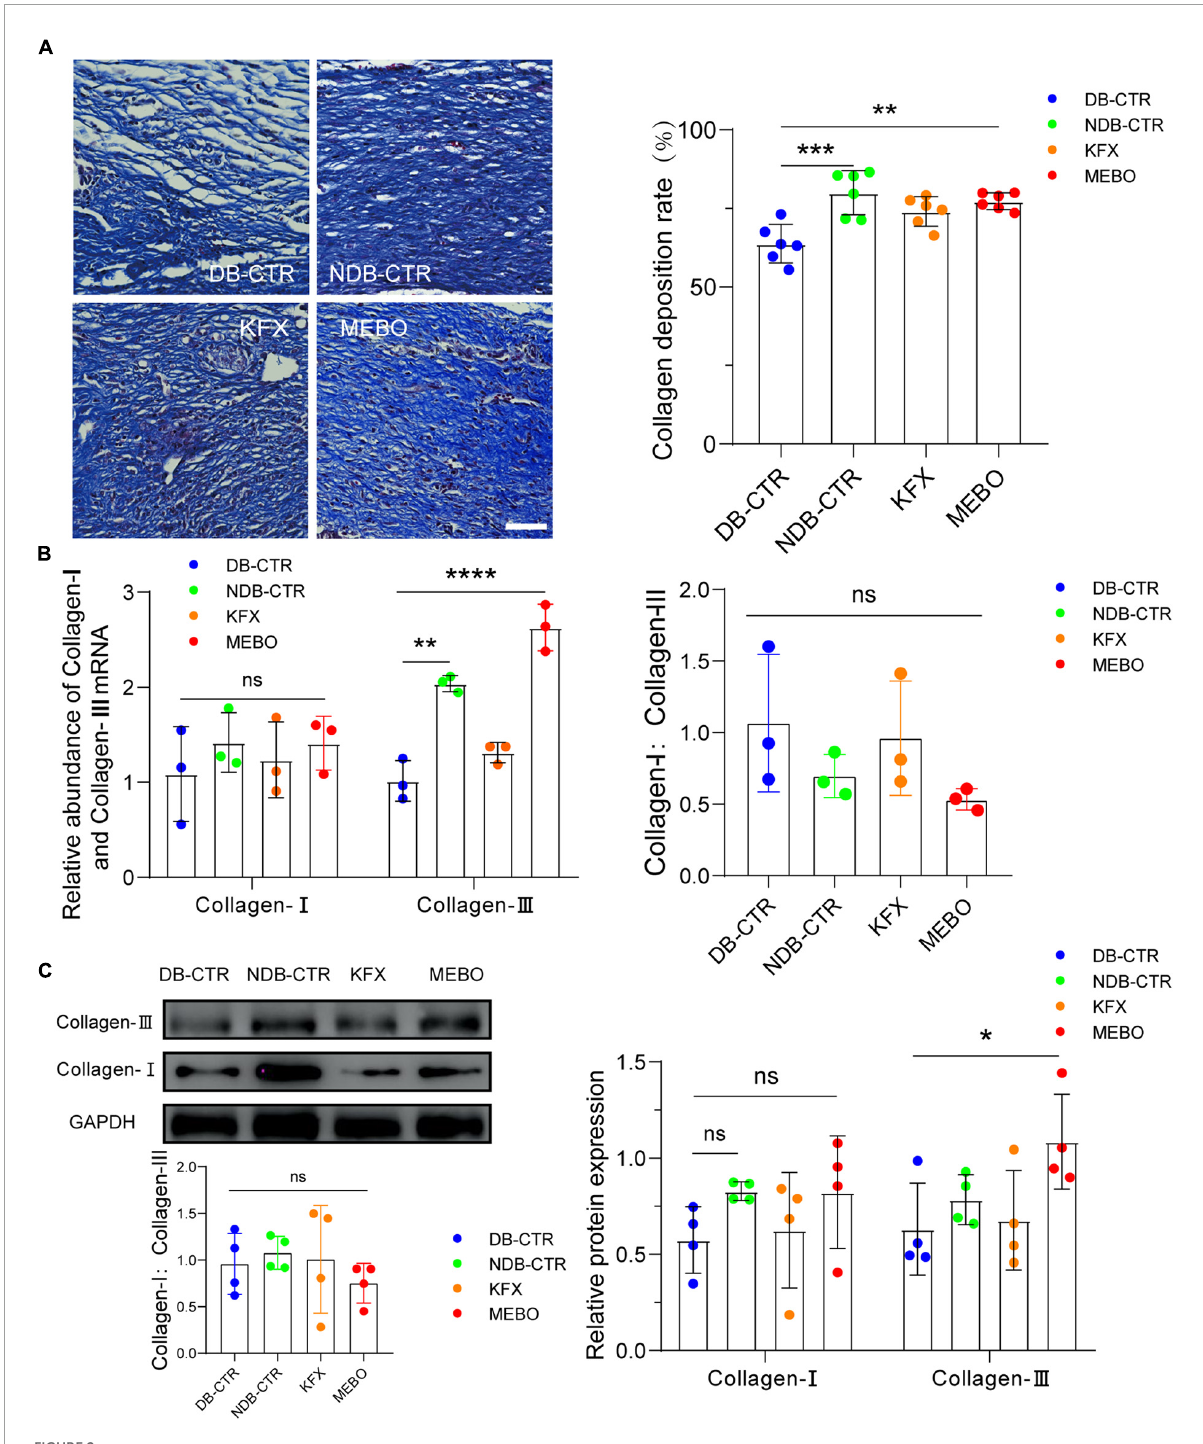
FIGURE2 MEBO accelerated collagen remodeling in diabetic wounds of mice. (A) Representative images of Masson staining of regenerated skin tissue of mice in each group. The scale is 50 µ m. The collagen remodeling of the regenerated skin of mice in each group was quantitatively analyzed by ImageJ software. (B) The mRNA relative contents of Collagen-I and Collagen-III of each group were compared by RT-qPCR. And the ratio of Collagen-I: Collagen-III were presented. (C) The protein expression of Collagen-I and Collagen-III of each group was determined by WB. And the ratio of Collagen-I: Collagen-III were presented. GAPDH serves as a loading control. The grayscale values of each strip were quantitatively analyzed by ImageJ software. At least 3 independent sections were chosen at each time for each group. All Data are shown as mean ± SD, ns P > 0.05, * P < 0.05, ** P < 0.01, *** P < 0.001, **** P <